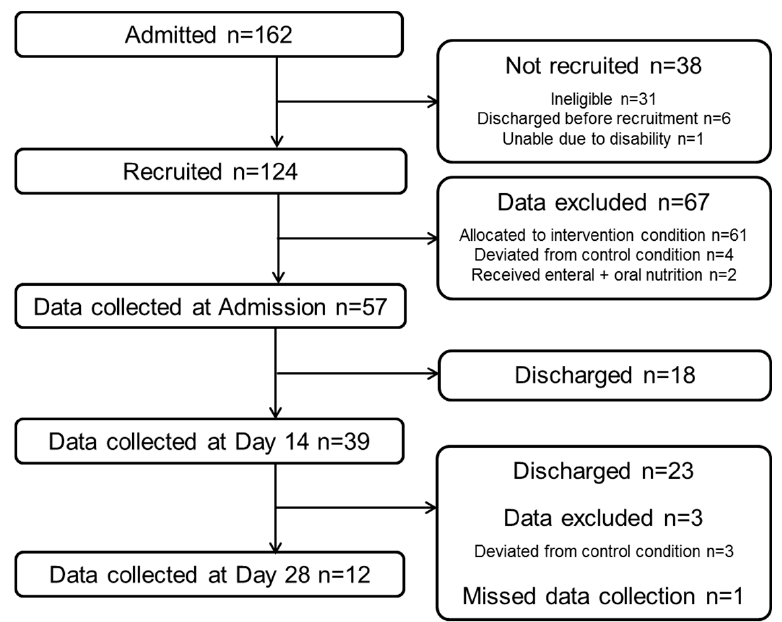
Figure 1. Participant recruitment, retention and data availability.